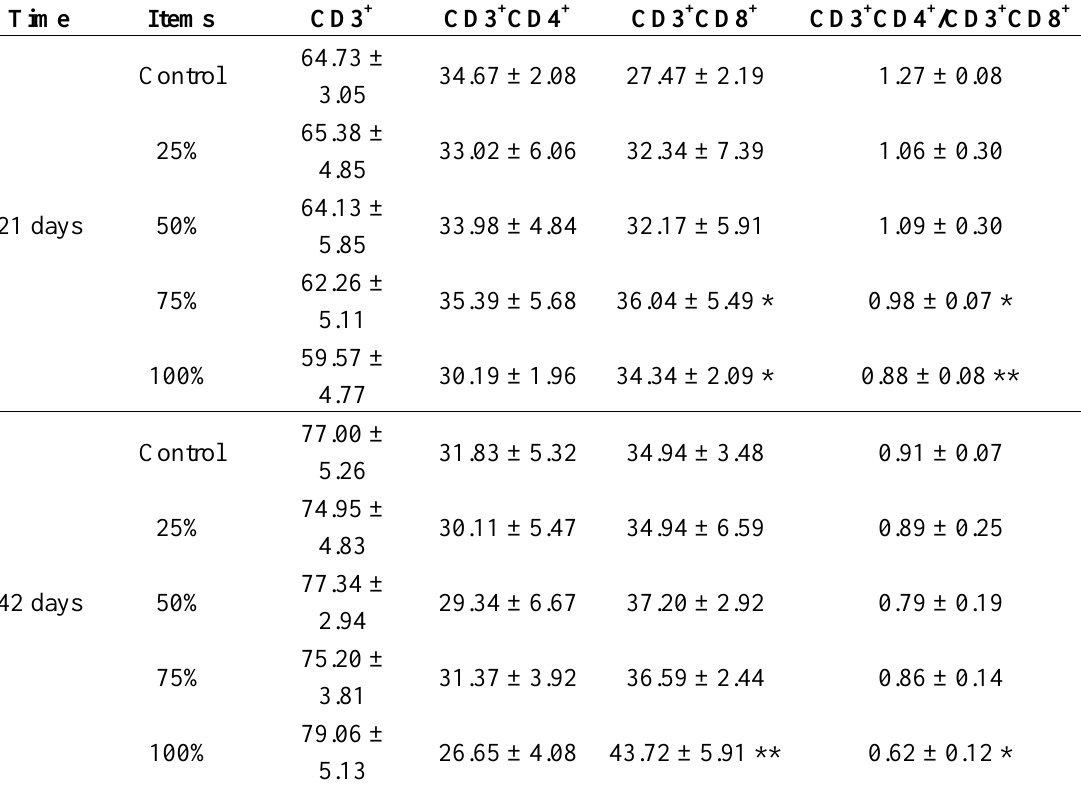
Table 3. Changes of splenic T-cell subsets